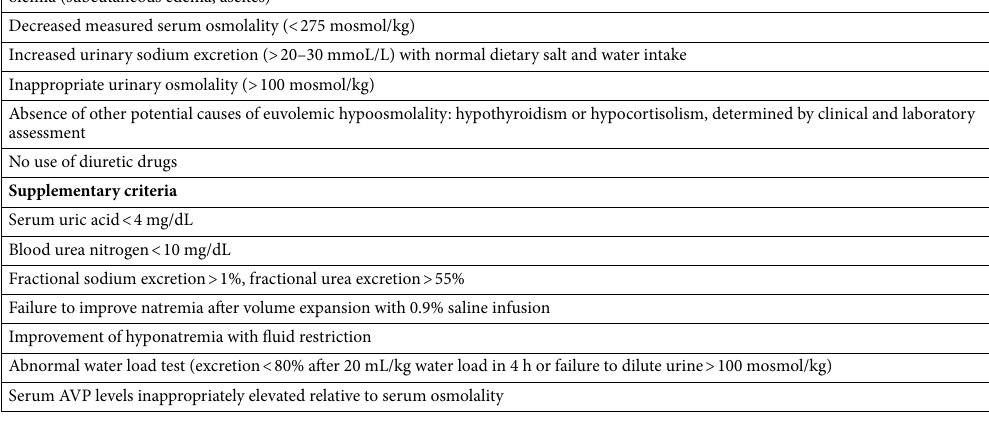
Table 1. Diagnostic criteria for